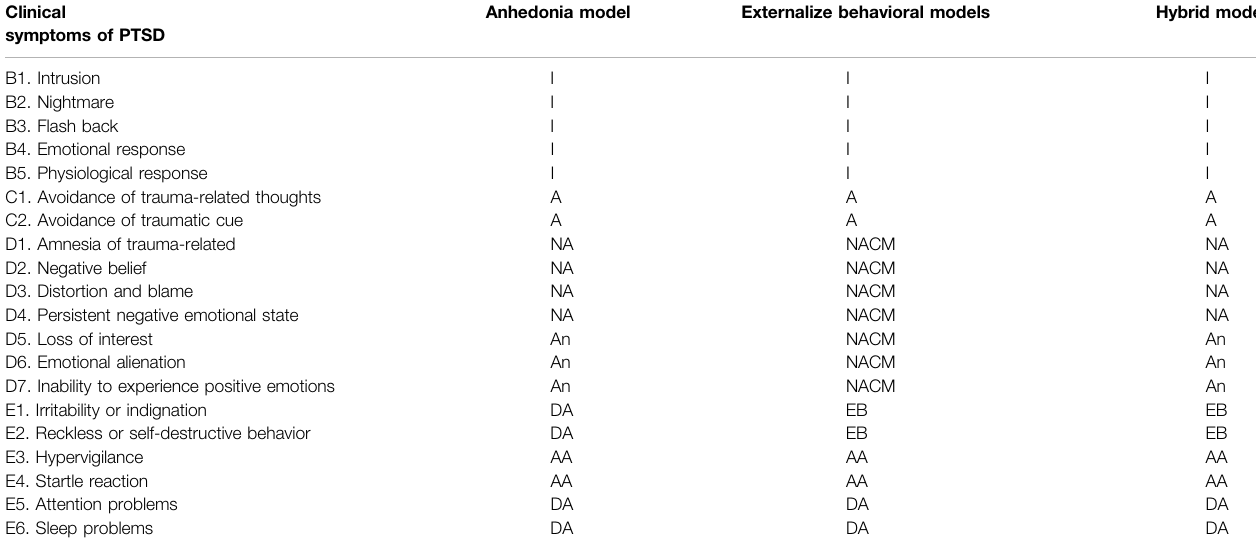
TABLE 5 | Re fl ection of clinical symptoms of PTSD in the DSM-5 phenotypic model. Clinical symptoms of